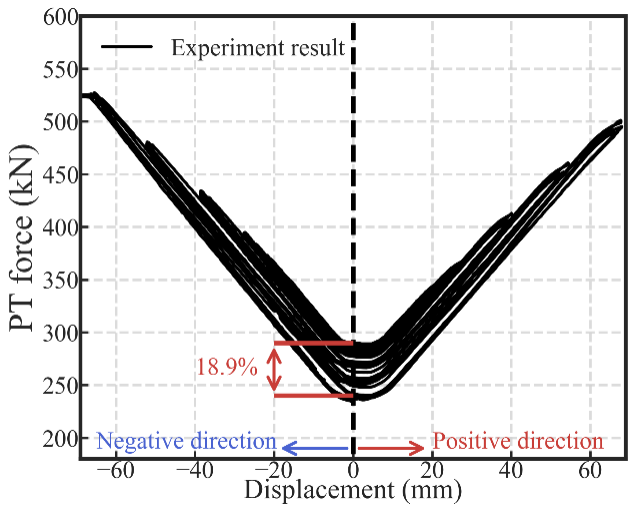
Figure 7. The variation of the PT force in the specimen.